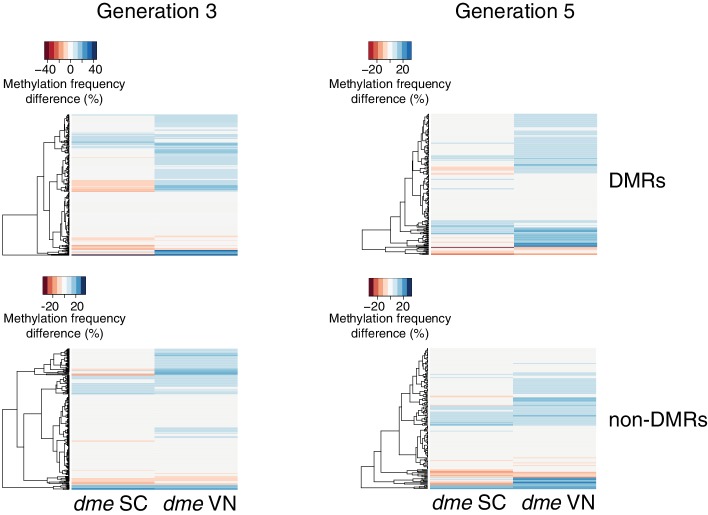
Methylation at hyperosmotic stress-induced DMRs in the dme-6 mutants.Methylation frequency difference in sperm cells (SC) and vegetative nuclei (VN); original sequencing data was taken from Ibarra et al. (2012). Differences were calculated by subtracting the methylation frequency of each DMR from its methylation frequency in the Col-0 wild-type control samples. Blue colour indicates hyper-, red colour indicates hypomethylation